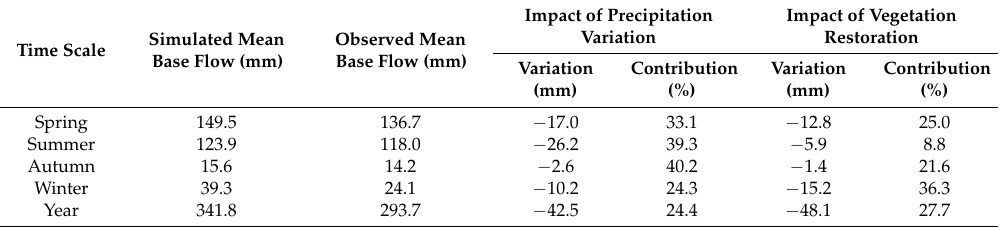
Figure 10. Relationship between observed base flow and precipitation in seasonal and annual scale during baseline period. Table 4. Calculated results of contribution rates of precipitation variation and vegetation restoration to base flow decrease.